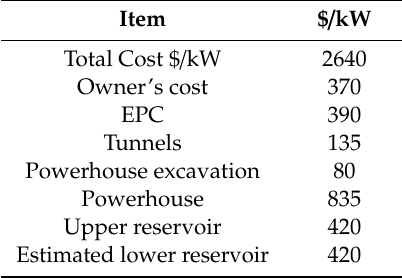
Table 22. Line item cost breakdown for a 16h pumped storage hydropower (PSH) plant.